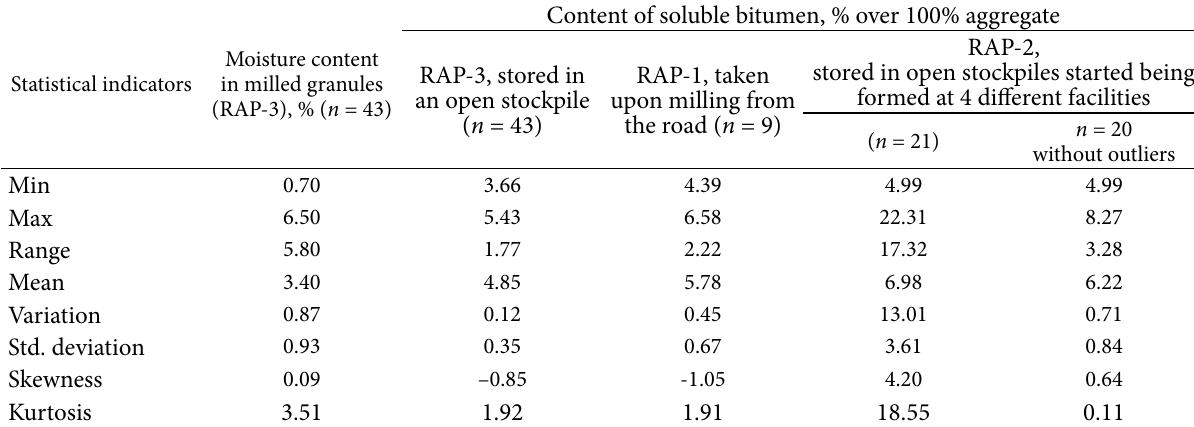
Table 2. Statistical indicators for moisture content in milled RAP granules and for content of old soluble bitumen binding RAP grains